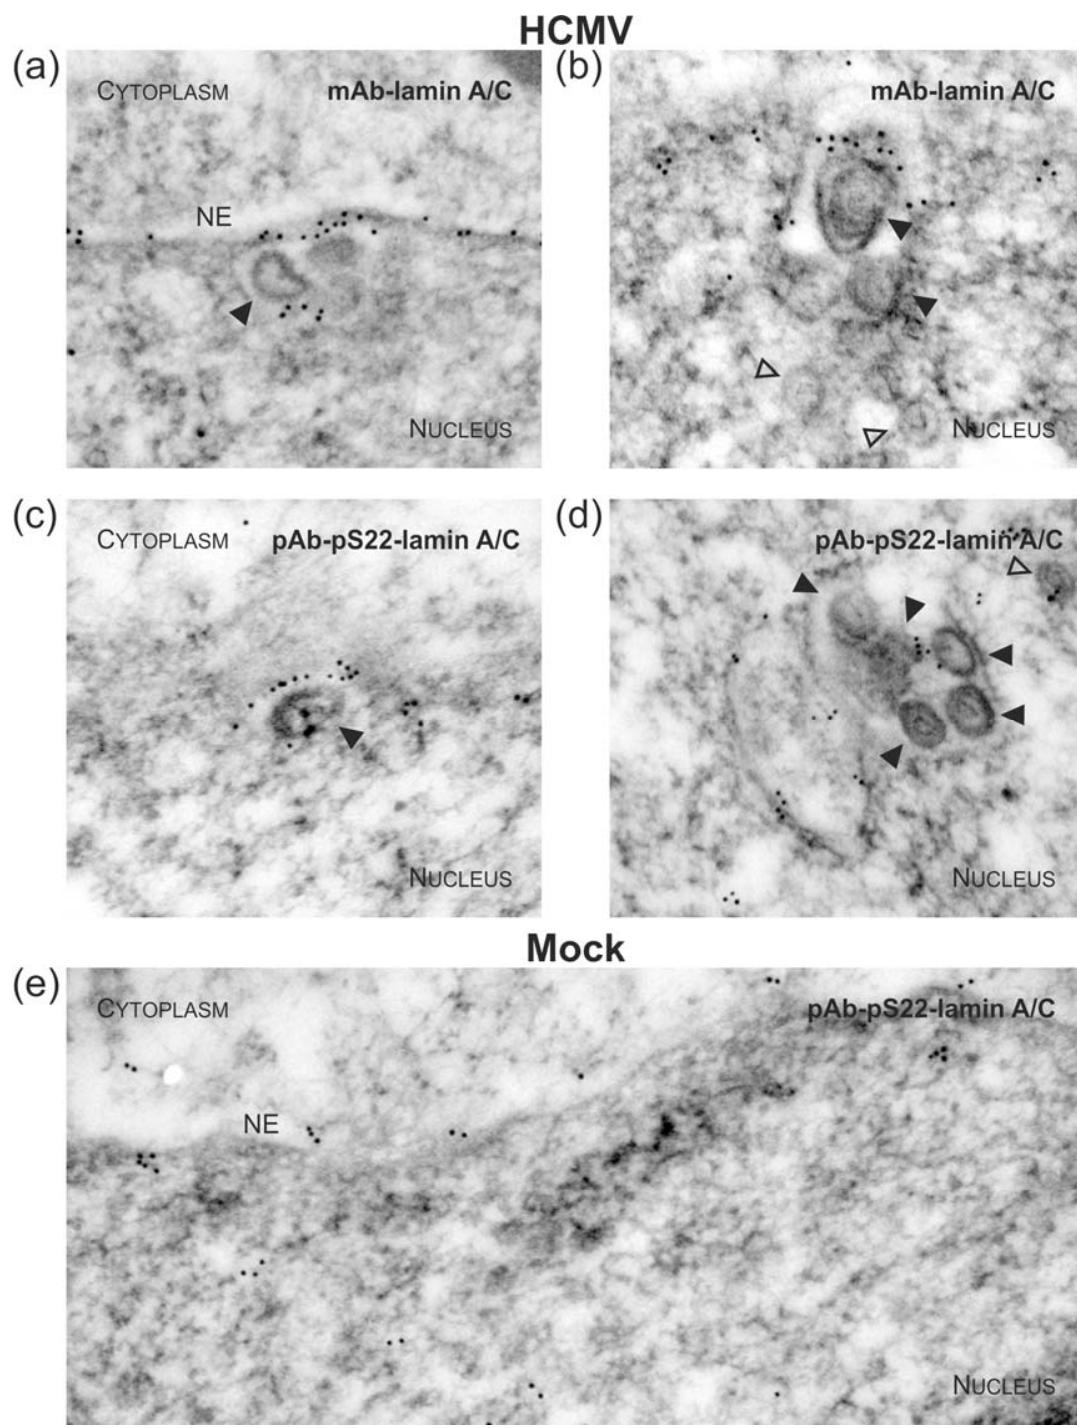
Figure 6. Accumulation of phosphorylated nuclear lamins at INM-budding sites of HCMV capsids during nuclear egress. HCMV-infected ( a – d ) or uninfected (mock; ( e )) HFFs were stained with phosphorylation-independent ( a , b ) or phosphorylation-dependent ( c – e ) lamin A/C primary antibodies and gold-tagged secondary antibodies. Samples were analysed by TEM, 35,970-fold magnification. NE, nuclear envelope; open arrowheads, intranuclear HCMV capsids; filled arrowheads, HCMV capsids budding at nuclear membranes.